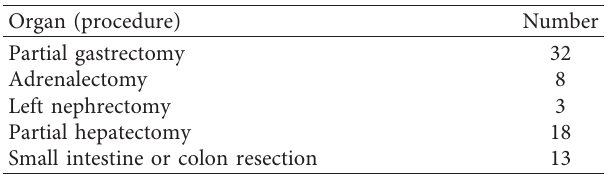
Table 2: Multivisceral distal pancreatectomy without the spleen ( n �